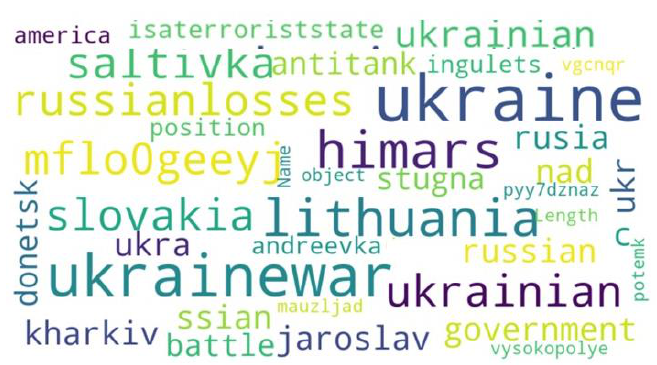
Figure 5. Word cloud of most buzzed words among the collected RUW tweets.